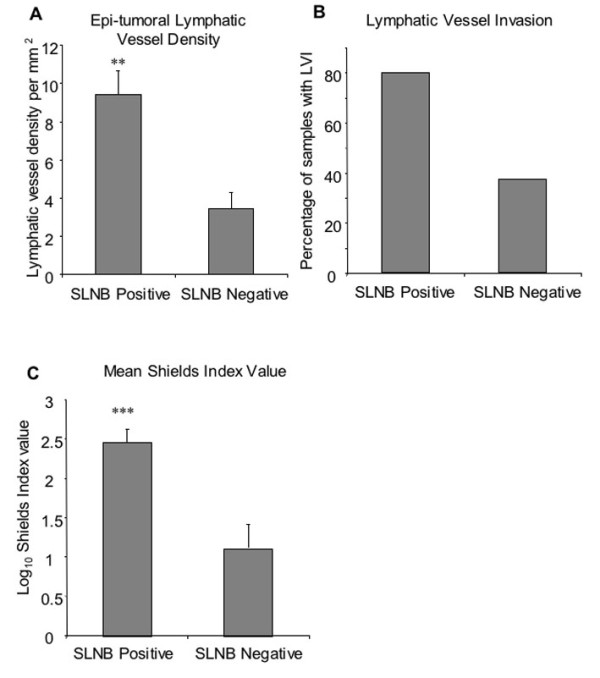
Comparison of epi-tumoural lymphatic vessel density, lymphovascular invasion, shields index and sentinel lymph node biopsy. Shields Index values were calculated on primary tumours from SNLB patients A) Mean epi-tumoural LD (p < 0.01, unpaired t test). B) Percentage of patients that were positive for LVI (p > 0.05, Fisher's Exact Test). C) Mean Shields Index values (p < 0.001, unpaired t test) for SLNB positive and negative patients. Error bars represent standard error of the mean.